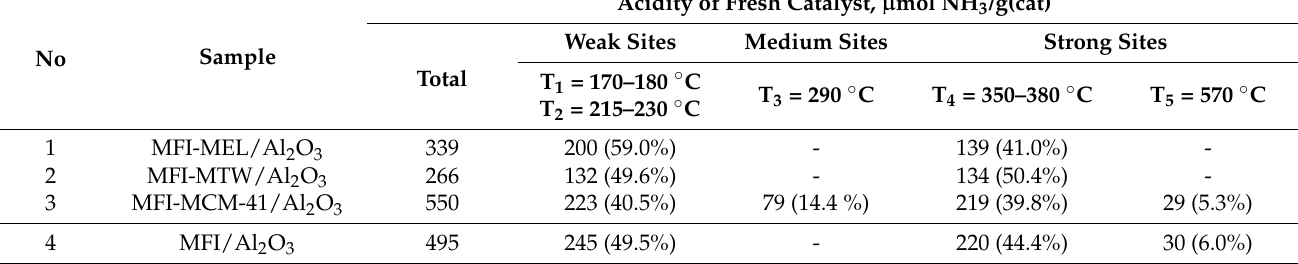
Table 2. Acidic properties of catalysts.